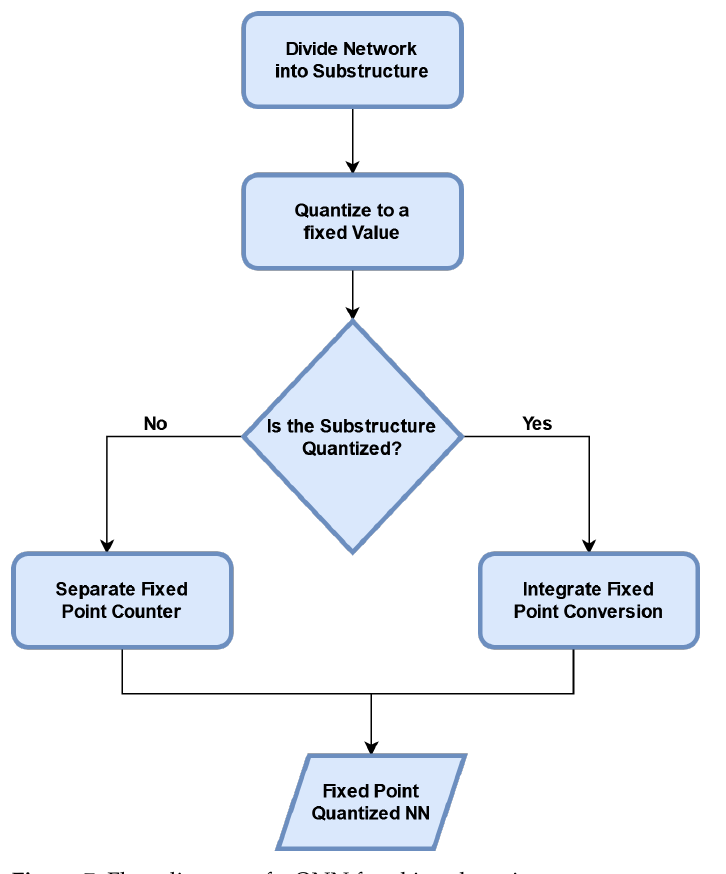
Figure 7. Flow diagram of a QNN for object detection. Figure 8 demonstrates the distribution for a convolutional kernel layer.